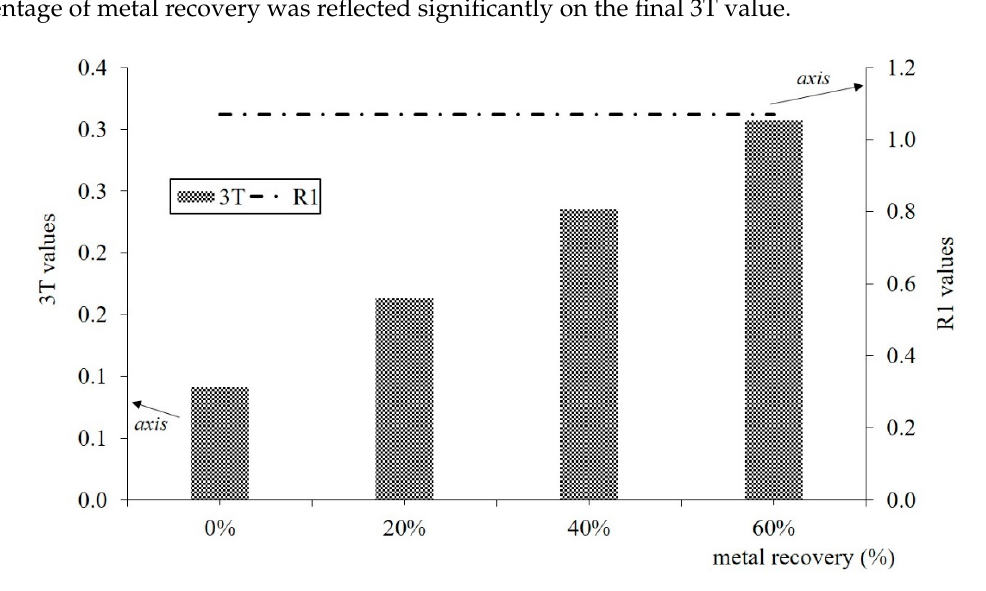
Figure 2. Results of applying the R1 formula and the 3T method for a waste-to-energy plant.